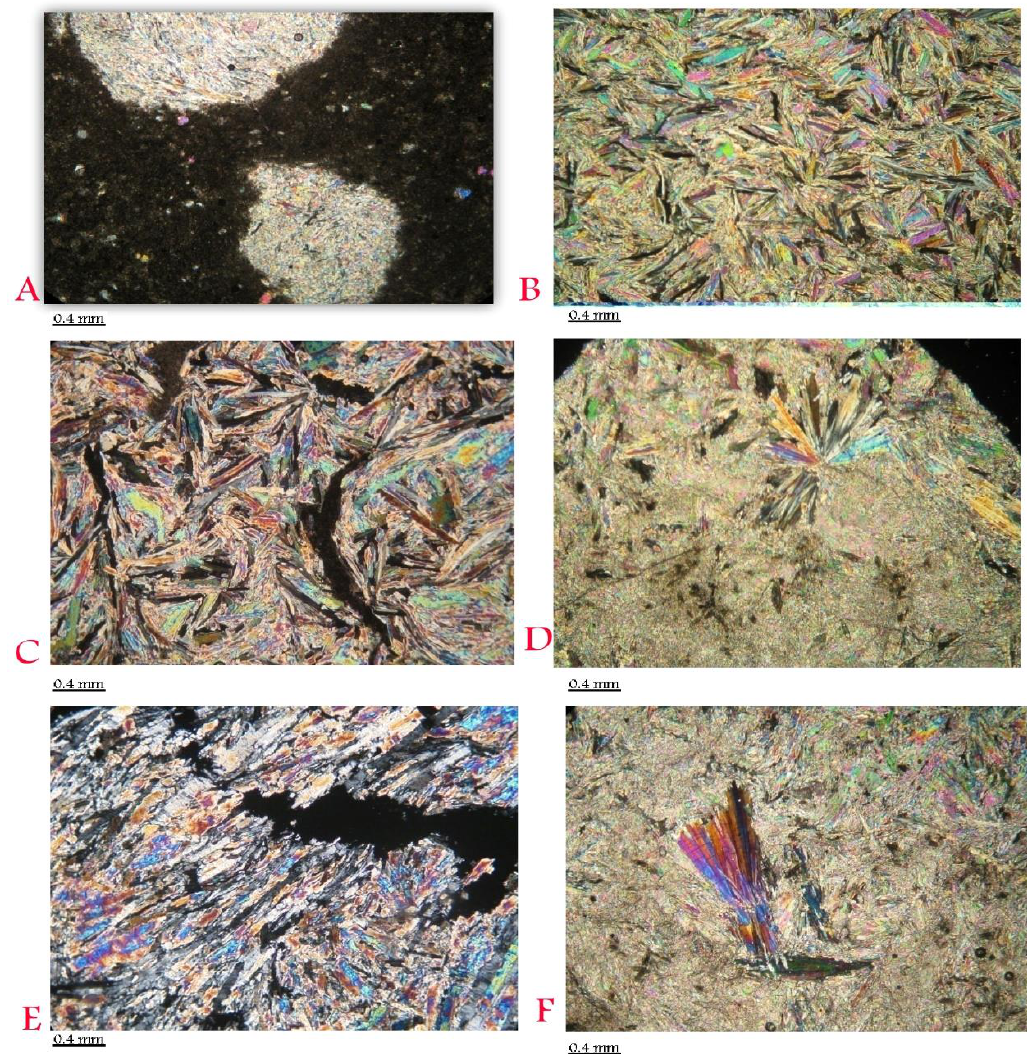
Figure 2. A-anhydrite nodule in a Madstone field, B-Decussate in anhydrite crystals, C-porphyroblast tissue in a field of fine-grained anhydrite, D- Radial texture in a field of microcrystalline anhydrite, E - Co-occurrence of course and fine anhydrite crystals next to each other, F-blowing texture in a background of microcrystalline anhydrite. Limestone (CaCO 3